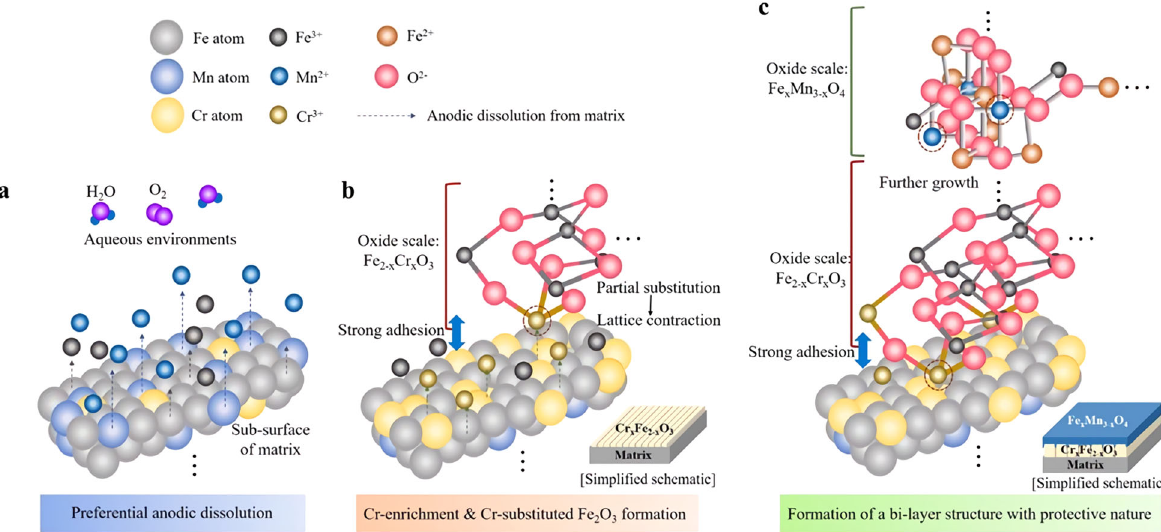
Fig. 7 Schematic diagram of the corrosion processes of high Mn – low Cr-bearing steels. a – c Initial, middle, and later stages in aqueous environments,